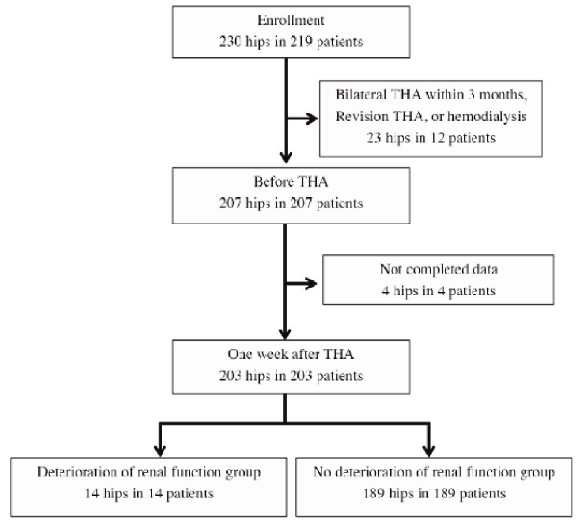
*THA – total hip arthroplasty Flowchart of patient selection. Fig. 1: